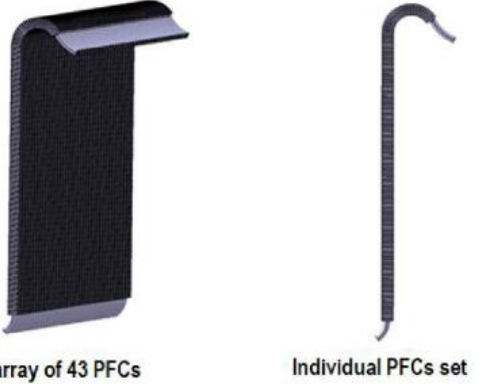
Figure 8. 3D view of a full outer target array of 43 PFCs ( left ) and individual PFCs set ( right ) [46]. An individual pipe can be arranged 78 and 70 W-monoblocks and the related